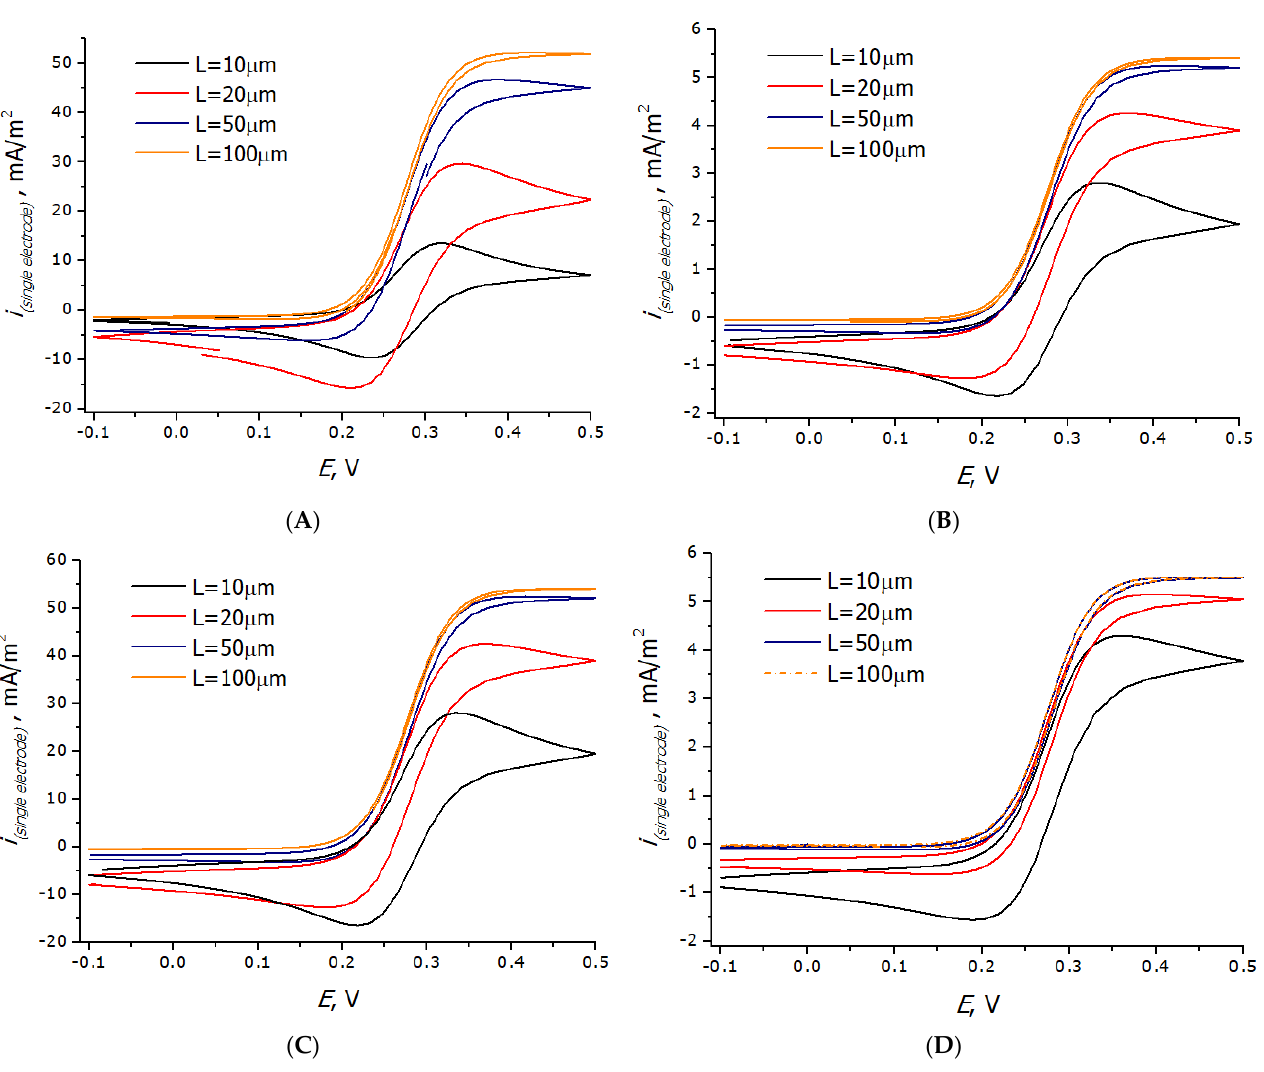
Figure 9. Series of current–voltage curves at different distances between the electrodes in the ensemble and different diffusion coefficients of analytes. ( A , C ): D = 7.4 ∙ 10 − 9 ; ( B , D ): D = 7.4 ∙ 10 − 10 . ( A , B ): scan rate 10 mV/s; ( C , D ): scan rate 100 mV/s.